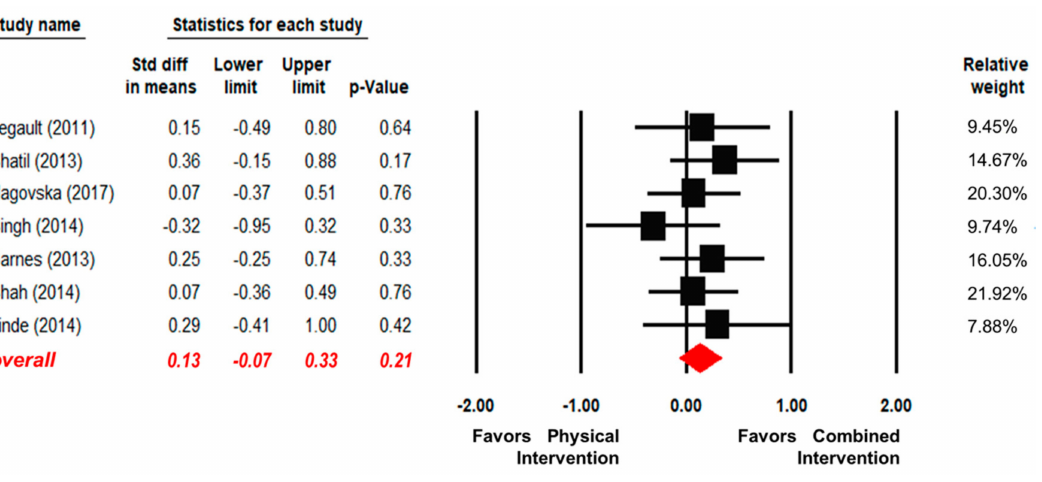
Figure 4. Forest plot for the e ff ect sizes of the combined interventions compared to the physical intervention